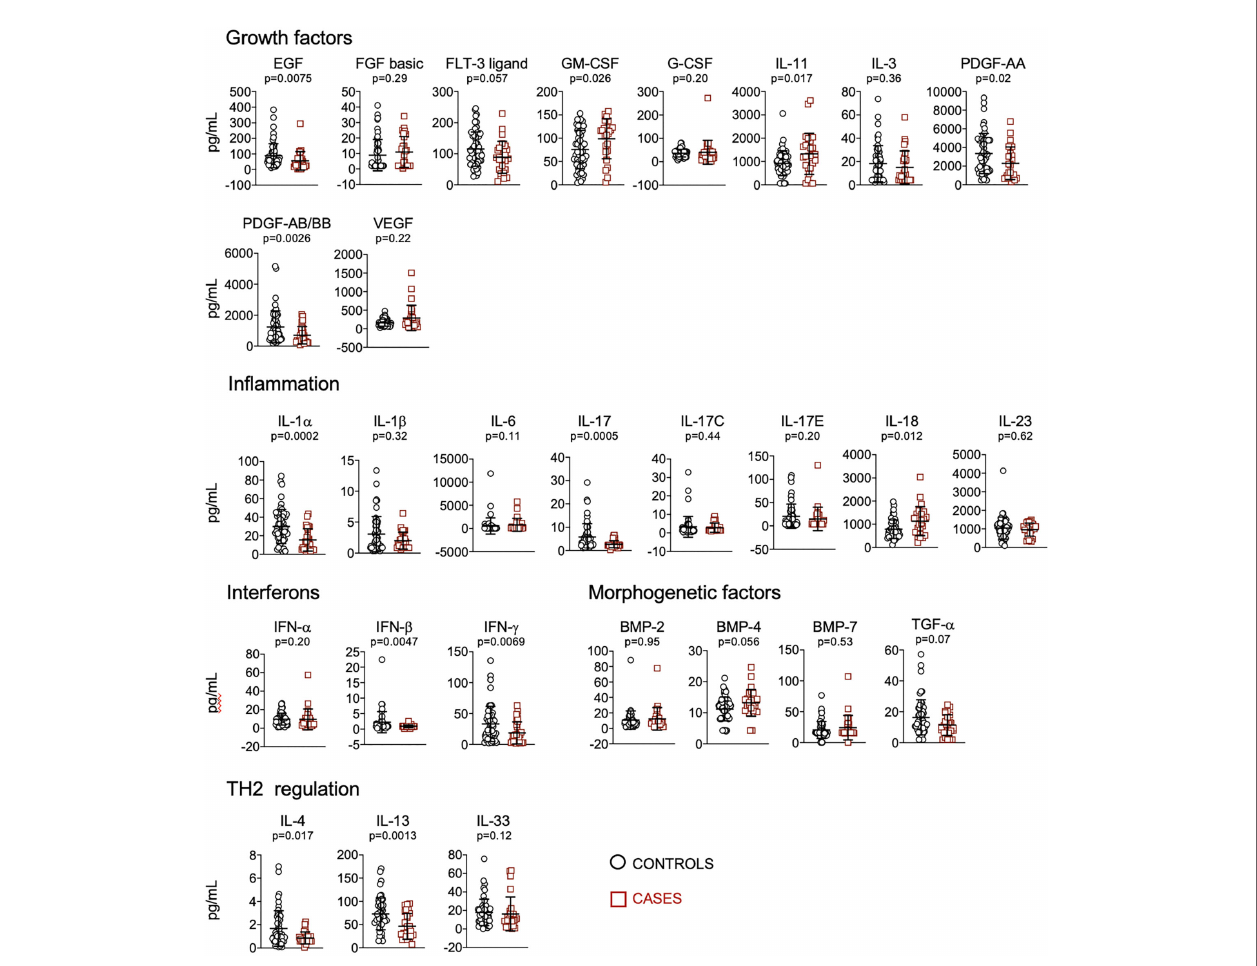
FIGURE 2 | Quanti fi cation of cytokines and other biomarkers involved in growth factors, in fl ammation, interferons, morphogenesis, TH2 regulation, in plasma obtained from controls (n=57) and cases (n=23). Data represent mean and standard deviation of the mean. Mann-Whitney test was used for statistical